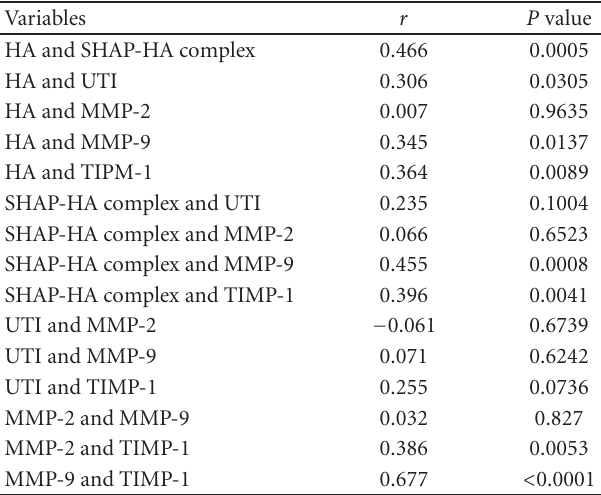
Table 5: Correlationship between the serum HA, SHAP-HA com- plex, MMP-2, MMP-9, TIMP-1, and UTI in patients with endome- trial